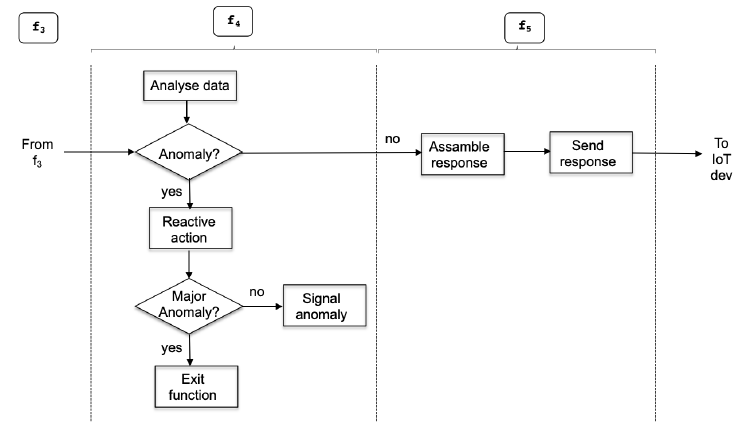
Figure 8. Anomaly/alarm detection and associated